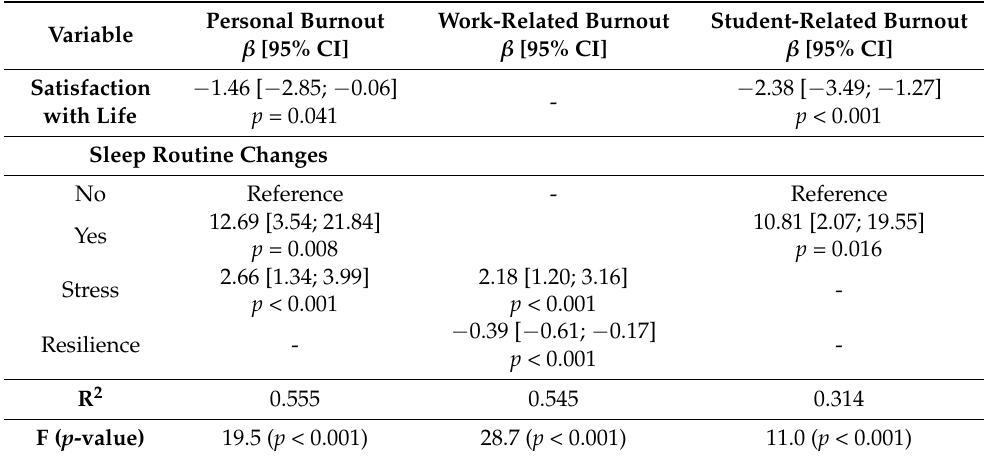
Table 4. Regression unstandardized coefficients ( β ) for CBI subscales as outcomes and socio- demographic, professional, and emotional variables as predictors from multiple linear regression